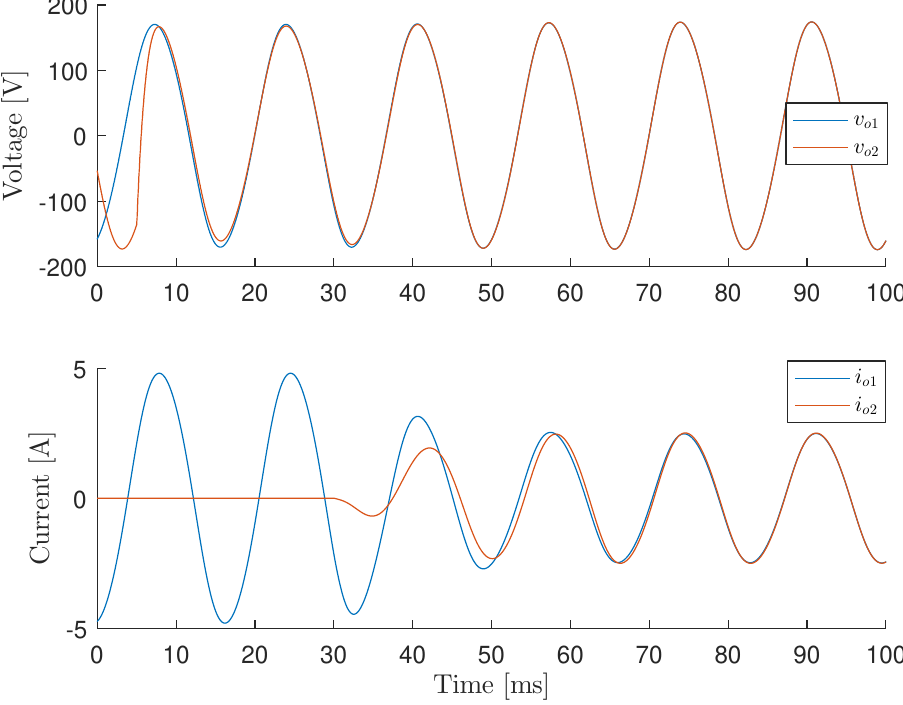
Figure 9. Synchronization of two oscillators designed with RM with pre-synchronization.